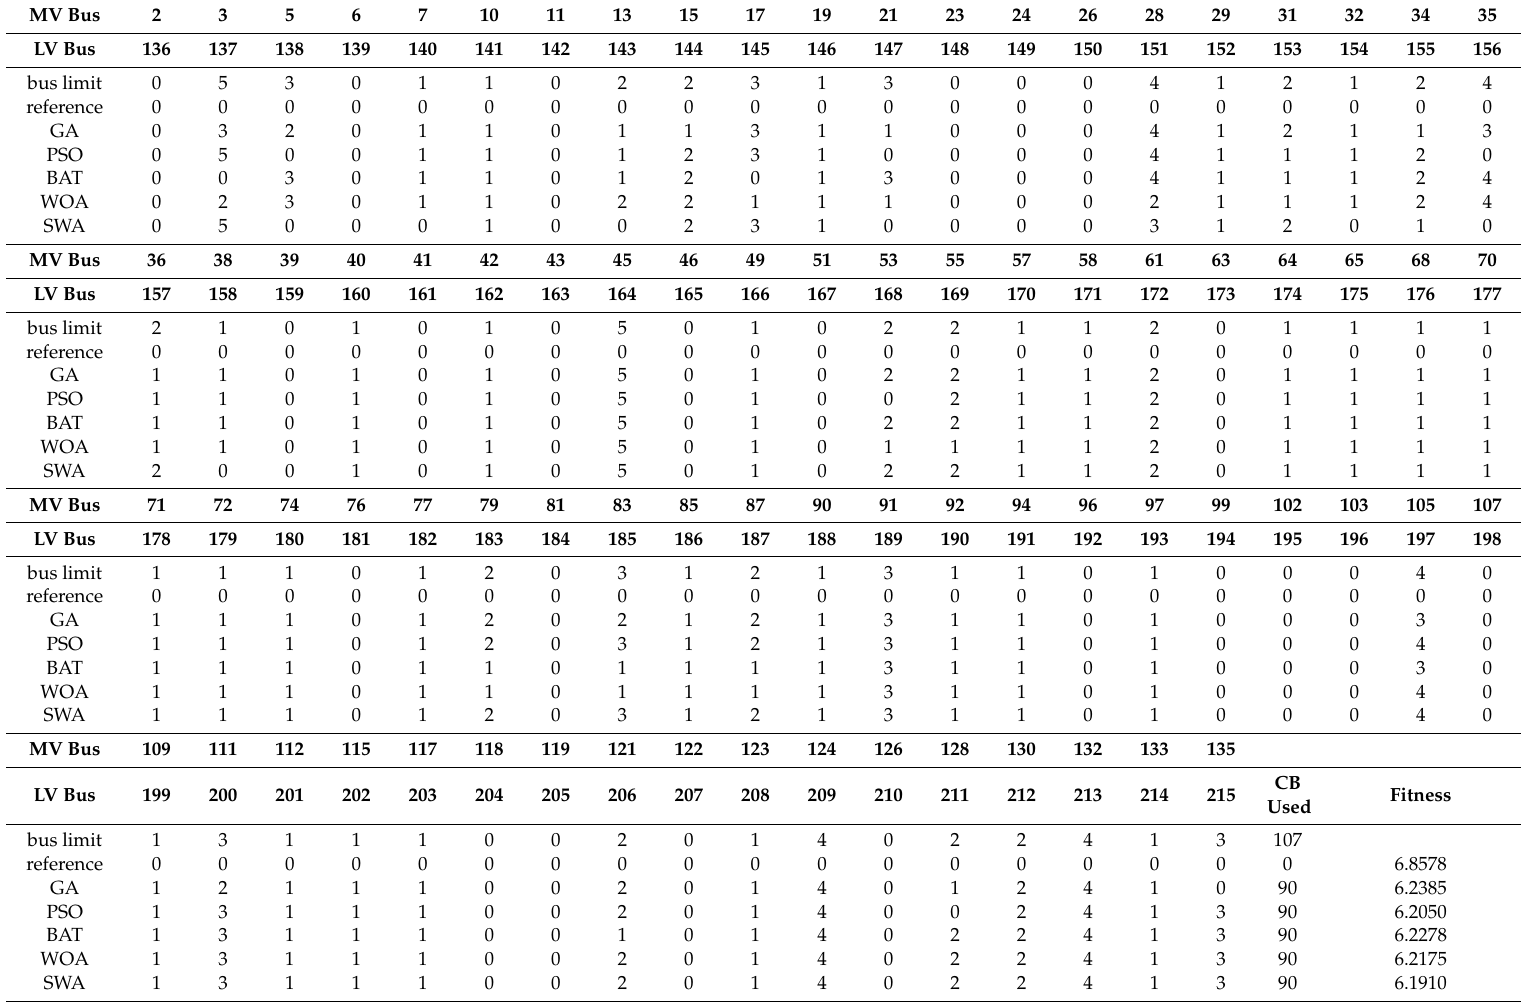
Table 12. The OCBA solutions found by the metaheuristic algorithms for the 215-bus